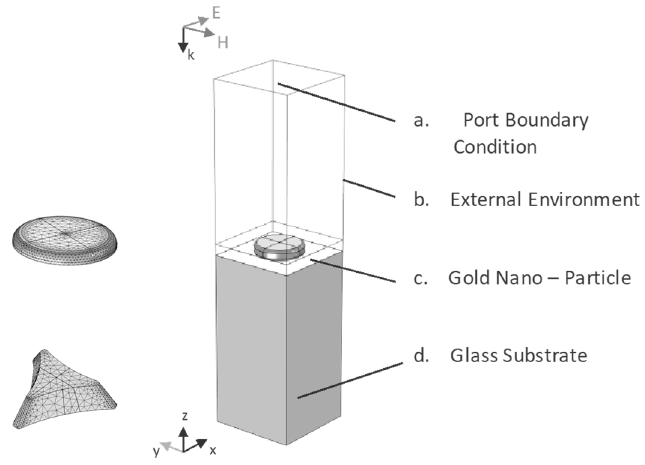
Figure 1. Schematic illustration of the model geometry used for the simulation of periodic array of Au nano-disks and nano-prisms on glass substrate; on the side, also the geometry and the mesh elements distribution of the simulated particles are reported.